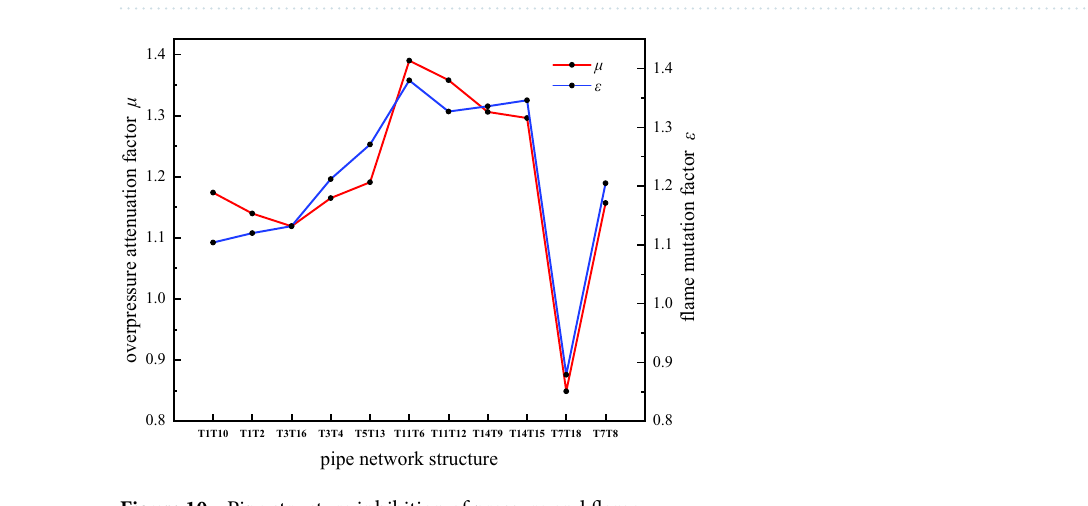
Figure 9. Overpressure attenuation factor and flame mutation factor of the pipe network. ( a ) μ ; ( b ) ε .